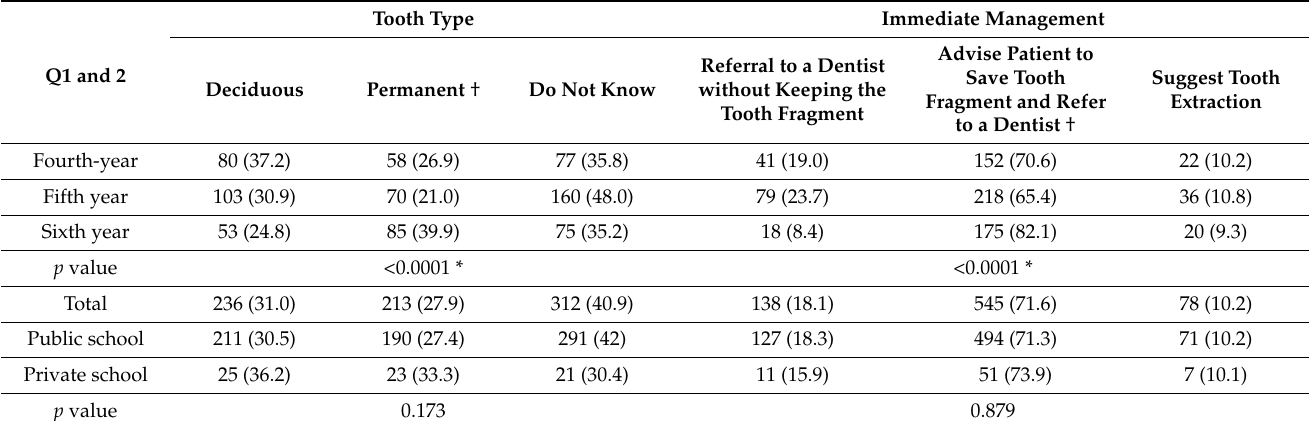
Table 1. The frequency and percentage (N%) of medical students’ responses to the first case scenario according to the academic level and school